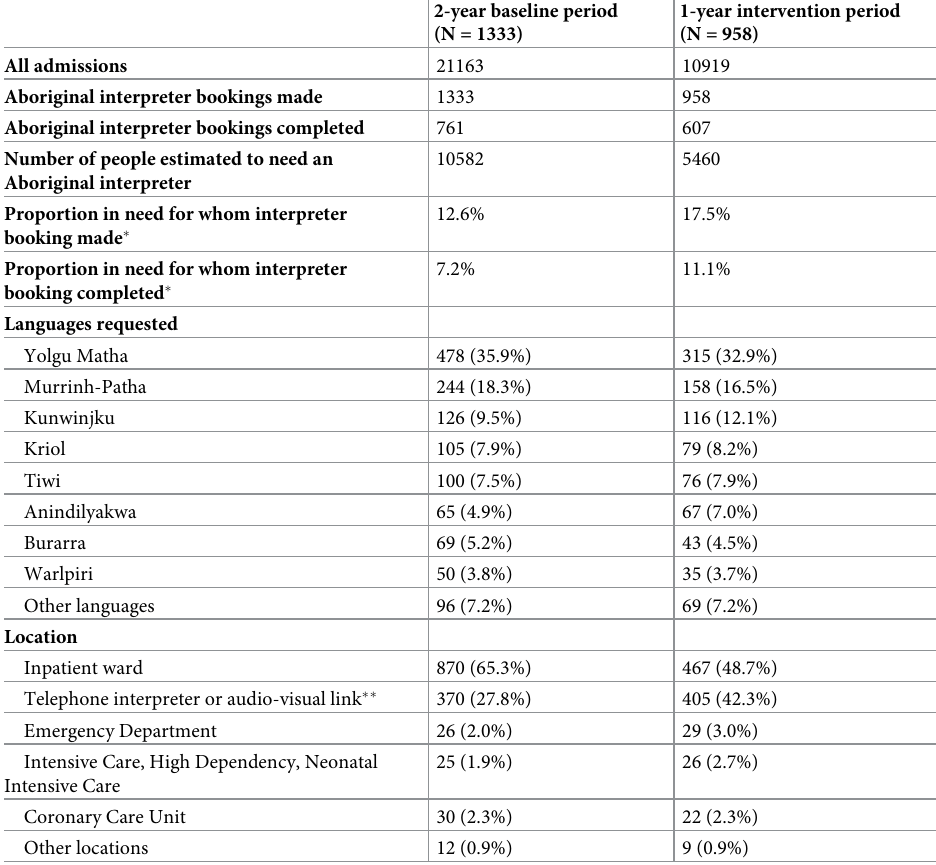
Table 1. Royal Darwin hospital separations (Aboriginal people) and interpreter booking requests during the base- line and intervention periods.